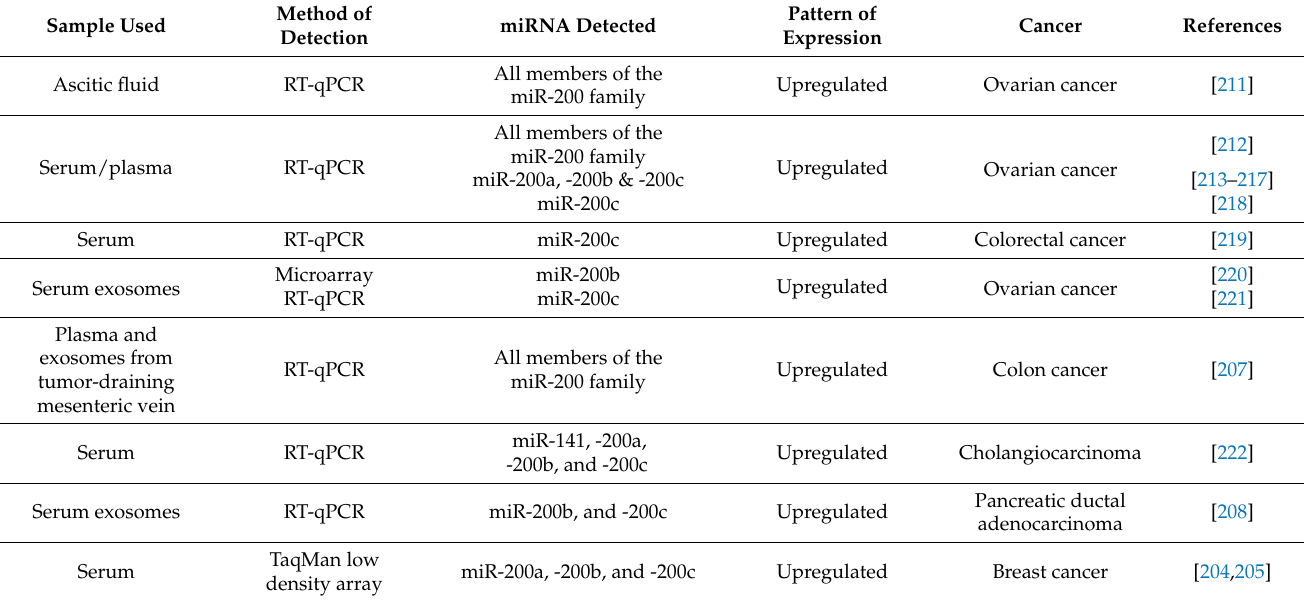
Table 4. A summary of differential changes in miR-200s expression as predictive biomarkers of multiple cancer types. The type of sample used and method of detection are also included. Sample